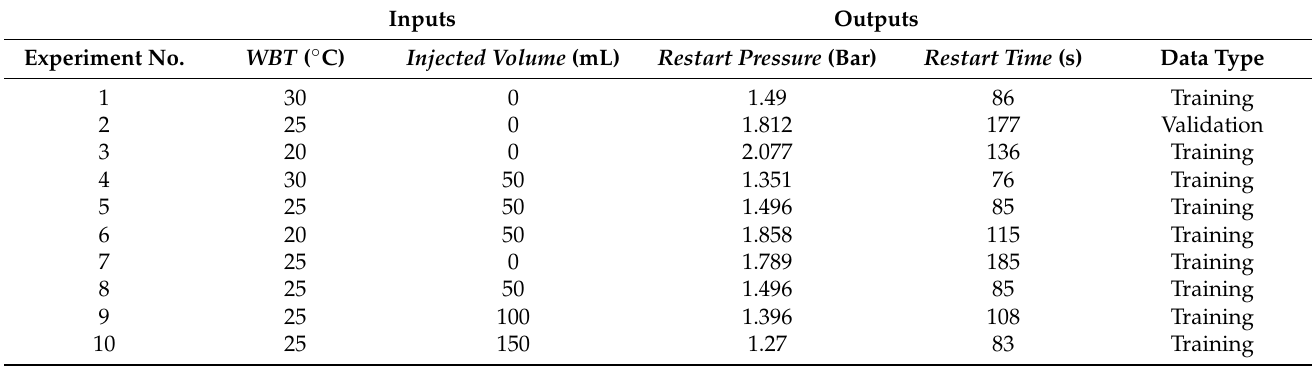
Table 1. Summary of the restart pressure and restart time of the gradual gas injection experiment.